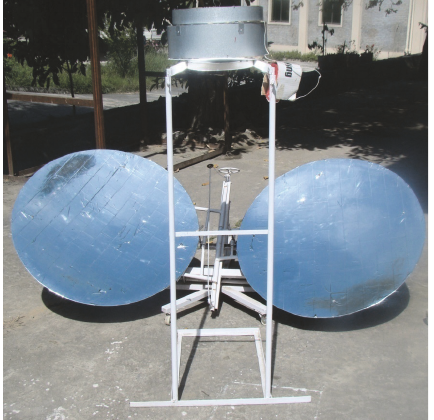
Figure 7: The dual parabolic re fl ector solar cooker in